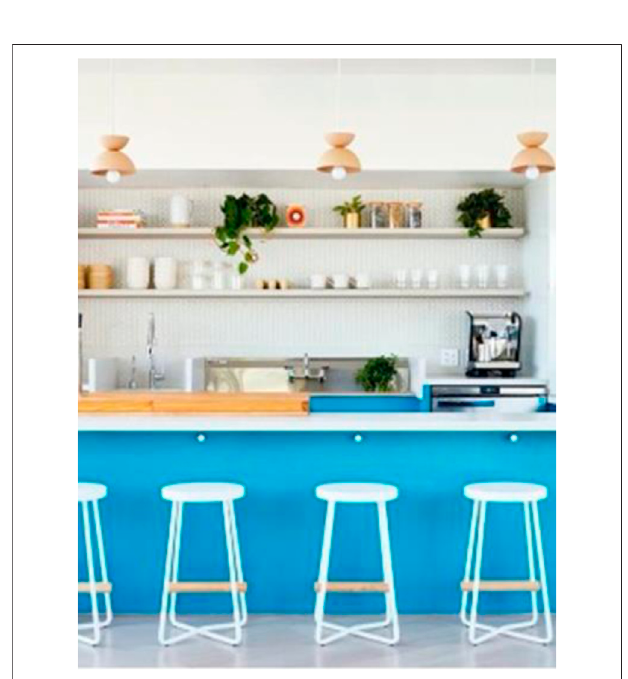
FIGURE 7 | Cafe: Credit Kara Ladd, Architectural Digest (2019), photography by Trevor